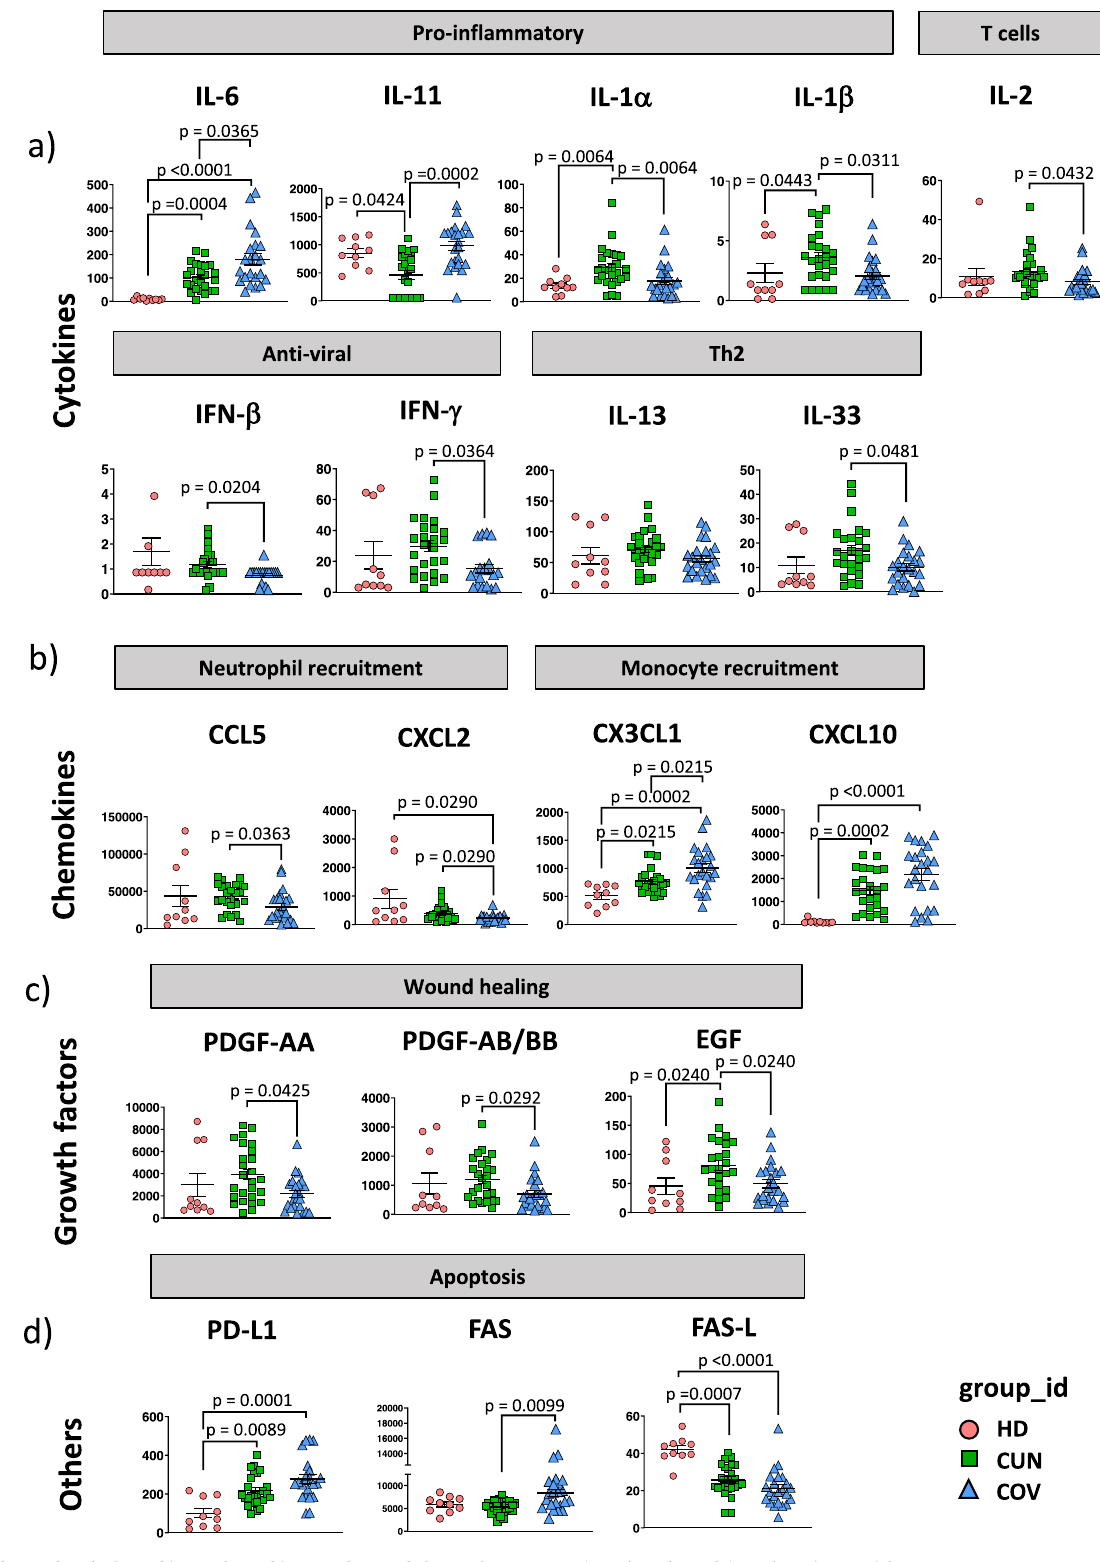
Fig. 1 Plasma level of cytokines, chemokines and growth factor from young (CUN) and aged (COV) patients with severe COVID-19. Scatter plots of 19 cytokines and other mediators in plasma obtained from healthy donors (HD, n = 10), CUN ( n = 26) and COV ( n = 23) subjects. Scatter plots show individual values, mean ± SEM. Kruskal-Wallis test with Benjamini-Hochberg correction for multiple comparisons was used to test the differences among the three groups; p -values are indicated in the fi gure. The upper bar indicates the function mediated by each plasmatic molecule. a Dotplots show the level of IL-6, IL-11, IL-1 α , IL-1 β , IL-2, IFN- β , IFN- γ , IL-13 and IL-33. b Dotplots show the level of CCL5, CXCL2, CX3CL1 and CXCL10. c Dotplots show the level of PDGF-AA, PDGF-AB/BB and EGF. d Dotplots show the level of PD-L1, FAS and